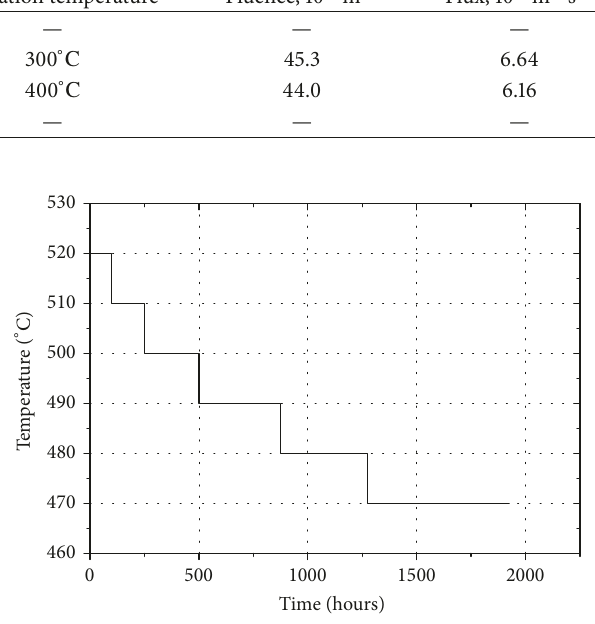
Figure 1: The mode of segregation provoking treatment [9].